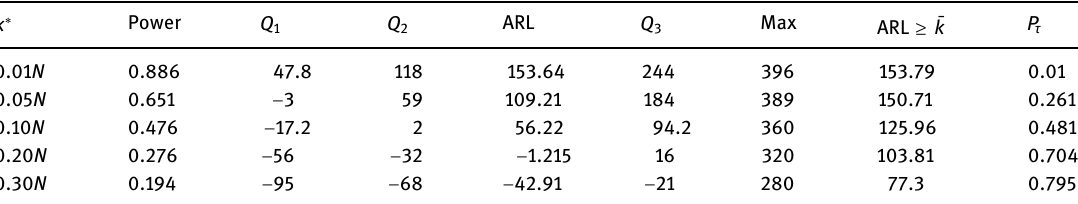
Table 6: Conditional powers, average of run lengths and probability of false alarms for CUSUM detection method under H A when = m N 100,